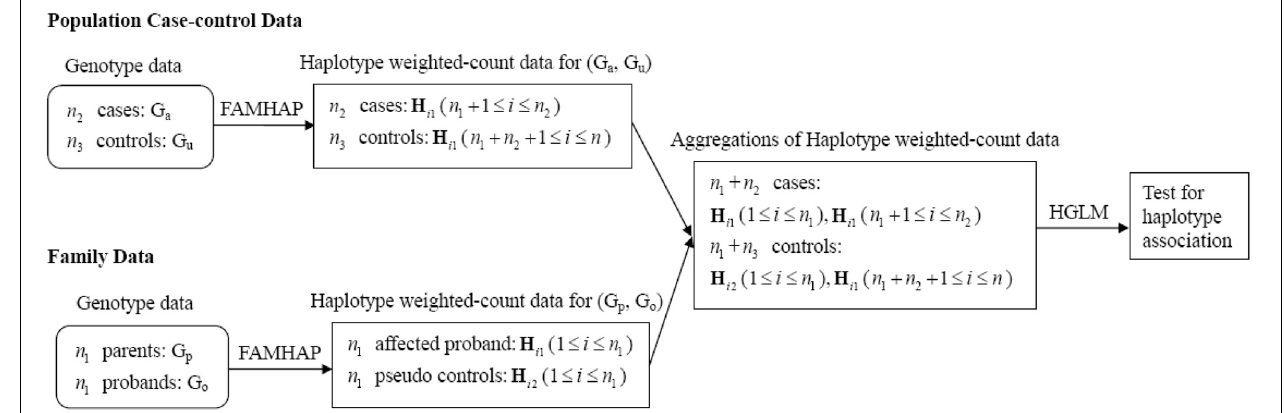
FIGURE 1 | Schematic diagram of HGLM for combining data of unrelated case-control samples and family